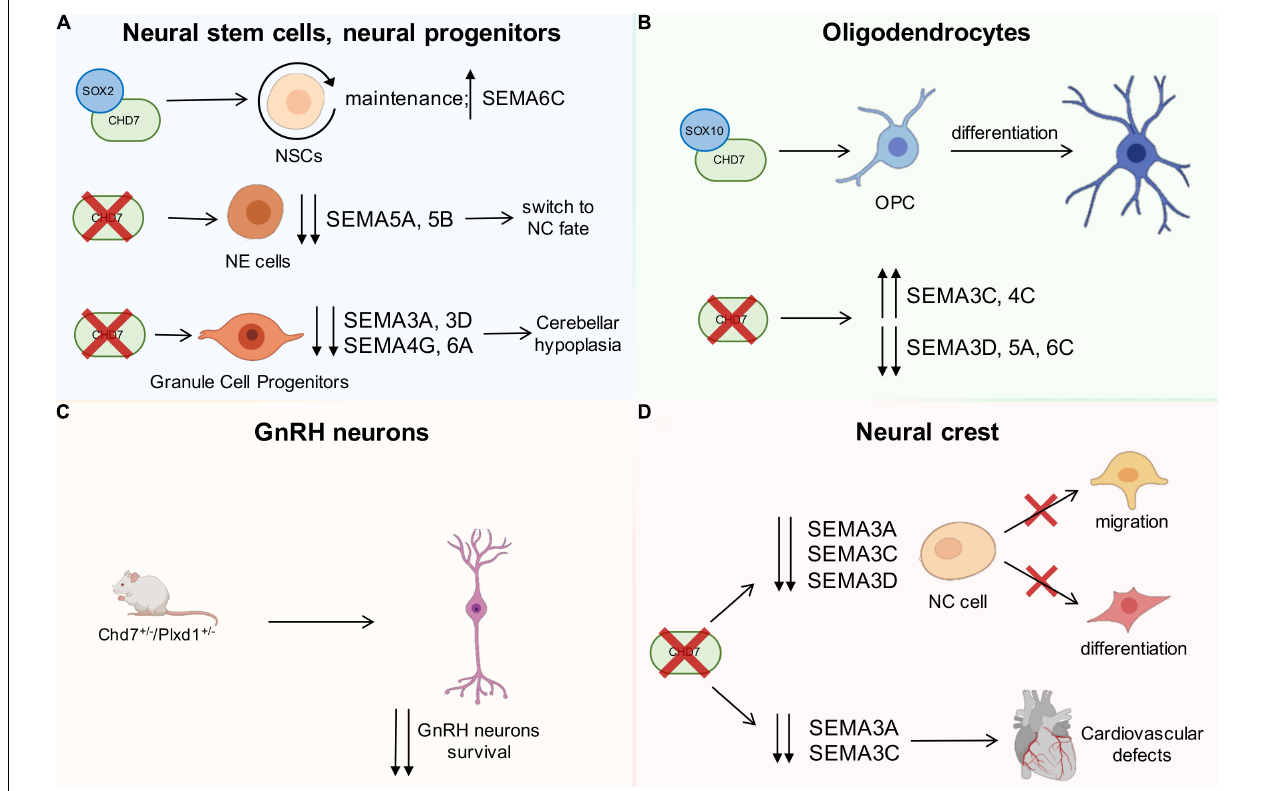
FIGURE 2 | Schematic drawing showing the interactions between CHD7 and semaphorins during development. (A) CHD7 interacts with SOX2 transcriptional cofactor, which is essential for neural stem cell maintenance, and the expression of SEMA6C is directly controlled by CHD7/SOX2 (upper part of the drawing). Insufficient CHD7 activity in neuroepithelial cells leads to downregulation of the indicated semaphorins and switch to a neural crest (NC) fate (middle drawing). In the cerebellum (bottom), CHD7 depletion in granule cell progenitors reduces the expression of the indicated semaphorins and leads to hypoplasia. (B) CHD7 is expressed in the oligodendrocyte lineage of the brain, and CHD7/SOX10 interaction leads to the differentiation of oligodendrocyte precursor cells (OPCs). CHD7 depletion in OPCs induces the upregulation of SEMA3C and 4C and the downregulation of SEMA3D, 5A, and 6C. (C) Compound heterozygous mice for the SEMA3E-receptor PLXND1 and CHD7 display a more significant loss of GnRH neurons compared to single heterozygous mutants. (D) CHD7 is highly expressed in NC pre-migratory cells, and its depletion causes the downregulation of SEMA3A, 3C, and 3D, which are known to regulate cell migration and differentiation. CHD7 is also expressed by a subset of NC cells that participate in the development of the heart. In this context, diminished SEMA3A and SEMA3C expression due to the absence of CHD7 leads to cardiovascular defects. Red crosses indicate a lack of the indicated gene or impairment of the indicated biological process; the up and down arrows indicate expression changes of the indicated